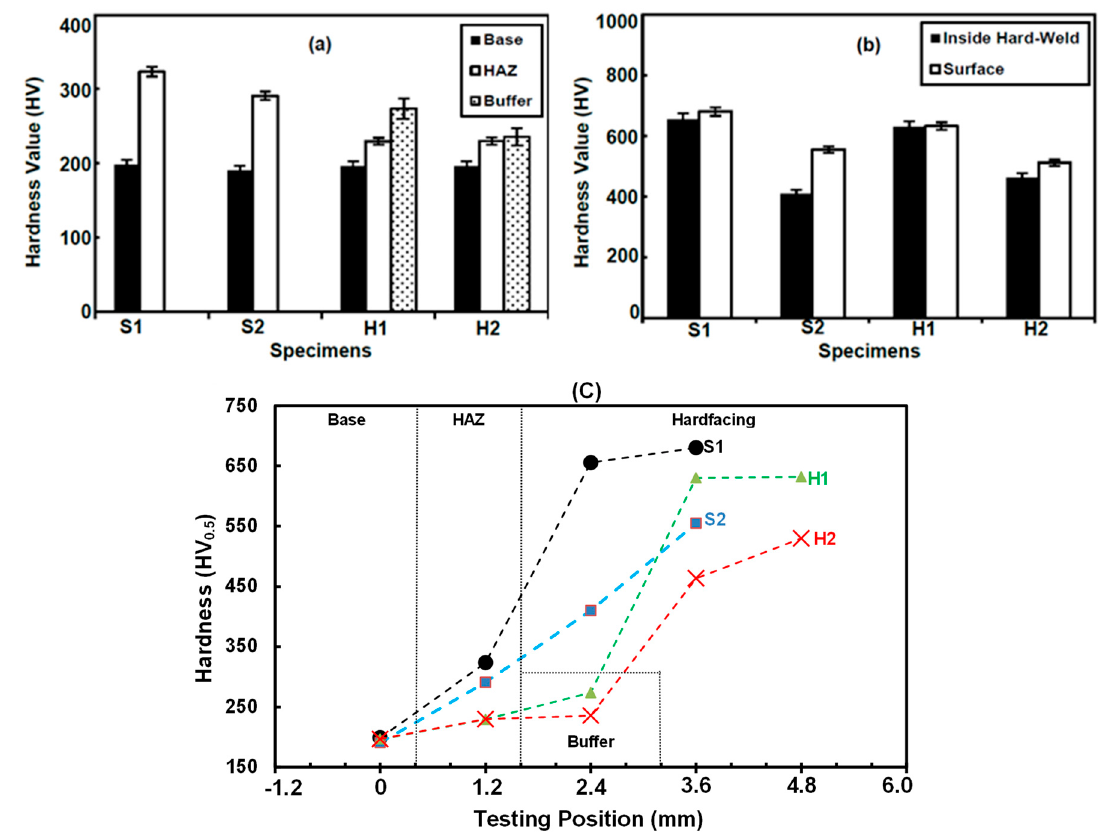
Figure 8. The hardness results of welded specimens at the areas of the ( a ) base, HAZ, and buffer; ( b ) interior and surface of the hard-weld; and ( c ) the hardness profiles in various zones of welded specimens ( • ) S1, ( (cid:4) ) S2, ( (cid:78) ) H1, and ( × ) H2.